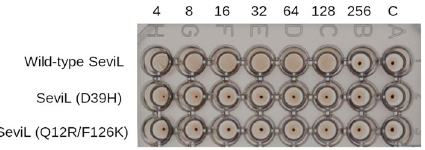
Figure 6. Hemagglutination of red blood cells by SeviL. 20 µ L of a two-fold dilution of SeviL (initially 10 mg/ mL) were serially diluted and added to the same volume of a red cell suspension containing 0.25% Triton-X100 and 10 mM calcium chloride, and incubated for 1 h at room temperature. Appearance of a dot indicates no agglutination. The number over the wells indicates the protein dilution factor. Top row: dimer SeviL, middle row: dimer SeviL (D39H), and bottom row: monomer SeviL (Q12R/F126K). Column C is a negative control with no added